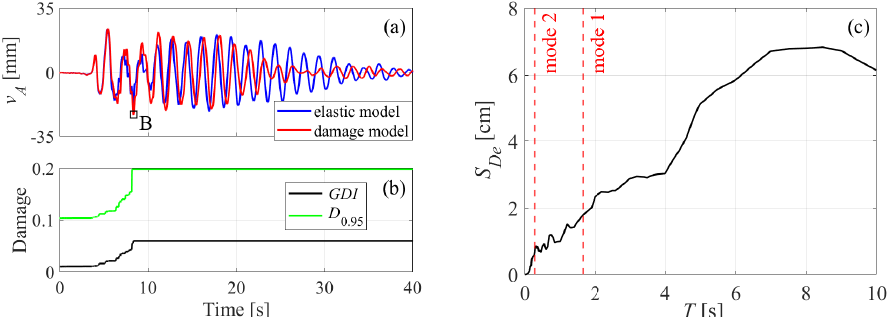
Figure 13. Earthquake MNF station: ( a ) elastic and damage responses of the equivalent pier, ( b ) evolution of the GDI and D 0.95 , ( c ) elastic displacement spectrum.